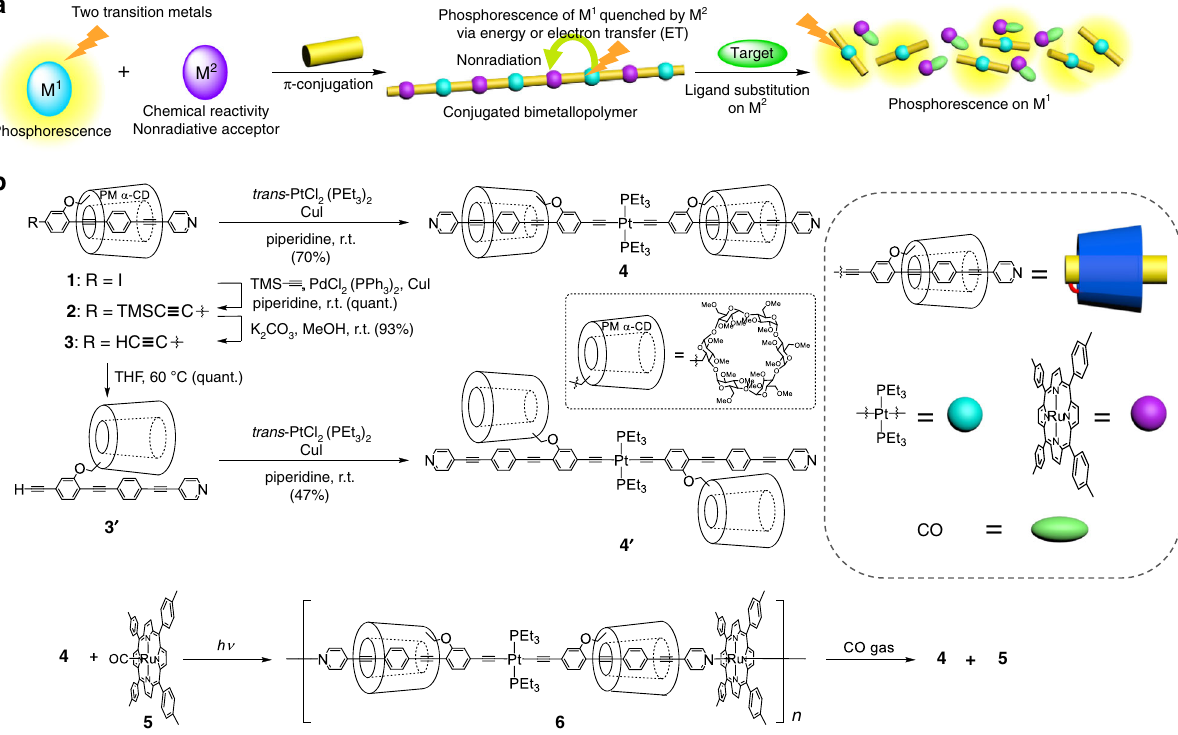
Fig. 2 Synthesis and response of bimetallopolymer. a Illustrations of the phosphorescence sensing mechanism based on a conjugated bimetallopolymer with two transition metals. b The synthetic route to the insulated conjugated bimetallopolymer 6